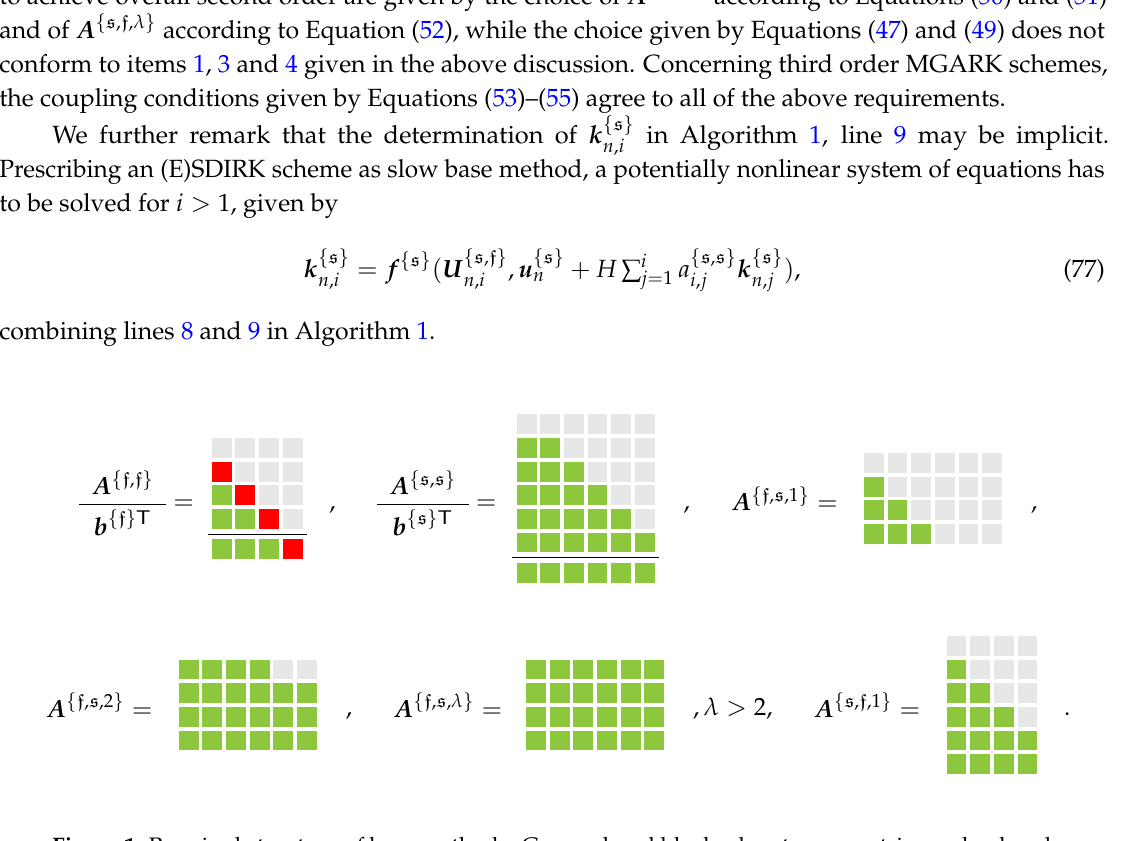
Figure 1. Required structure of base methods. Gray-colored blocks denote zero entries, red-colored blocks denote entries required to be non-zero, green-colored blocks symbolize arbitrary